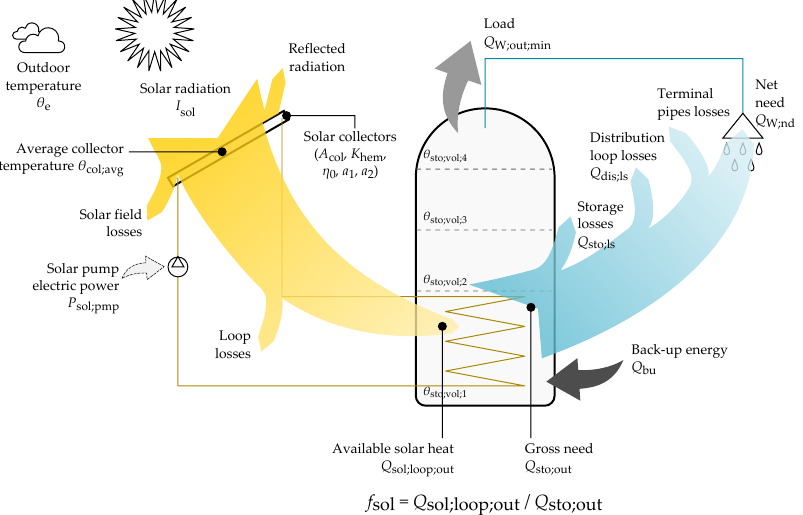
Figure 1. Energy flows in a forced-circulation solar